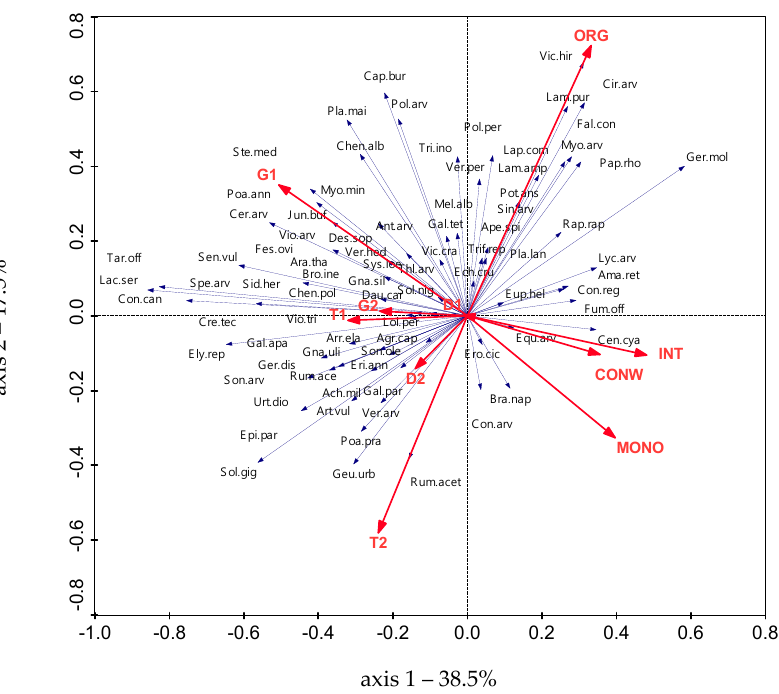
Figure 11. Ordination diagram of species and agrotechnical variables in relation to the first and second axis of RDA (RDA diplot) using CANOCO. Explanations of symbols: ORG—Organic, INT—Integrated, CONW—Conventional, MONO—Monoculture of winter wheat, T—Trees and bushes, D—Dicotyledonous, G—Grasses, 1—2010–2012, 2—2013–2015 .